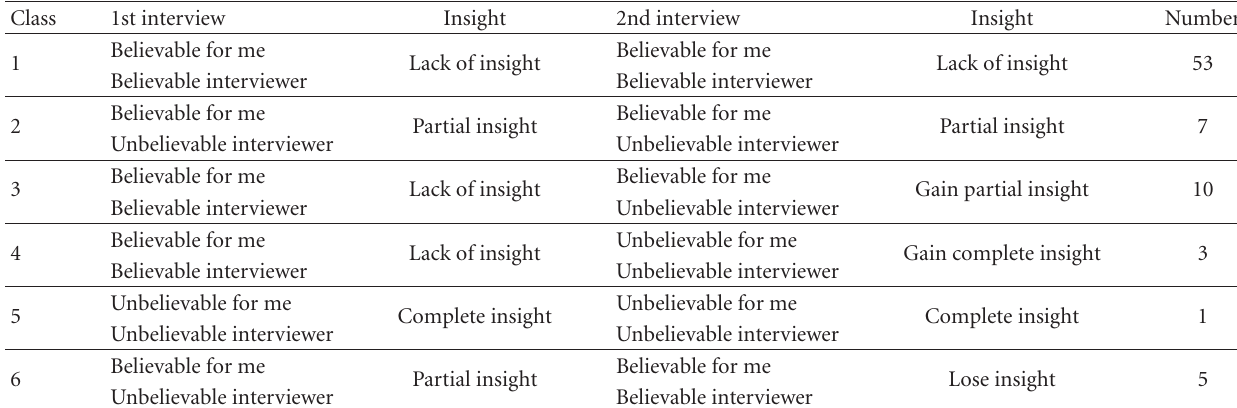
Table 3: Patients were divided into classes according to the answers they gave to the questions that they were asked after the first and the second interview. Based on the responses the patients could be classified as either having lack of insight, loss of insight, partial gain of insight, or complete gain of